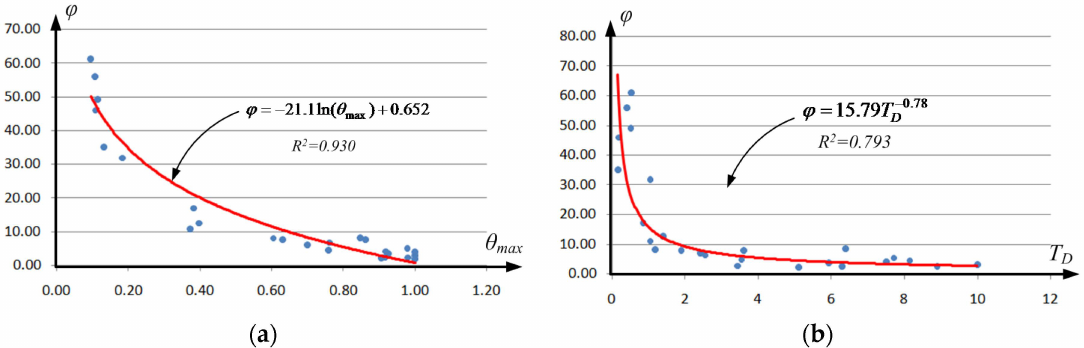
Figure 8. ( a ) Resistance vs. θ max ; ( b ) Resistance vs. down time.